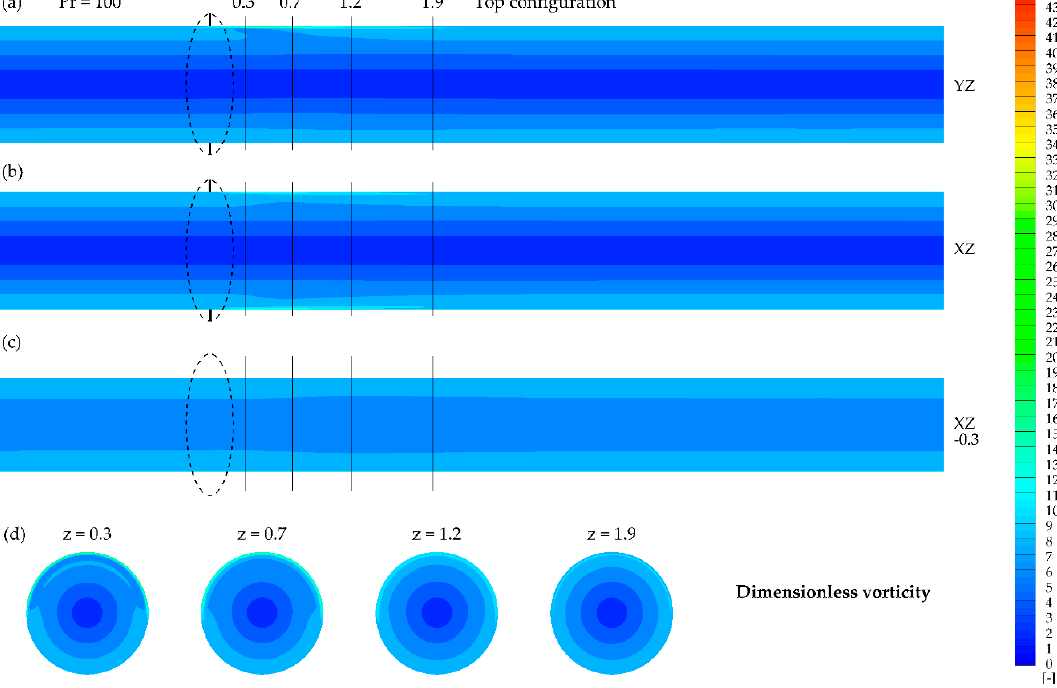
Figure 18. Dimensionless vorticity contours obtained for Pr = 100 and top configuration in the presence of the magnetic field at: ( a ) YZ plane, ( b ) XZ plane, ( c ) XZ plane ( y = − 0.3), ( d ) XY planes at given z .